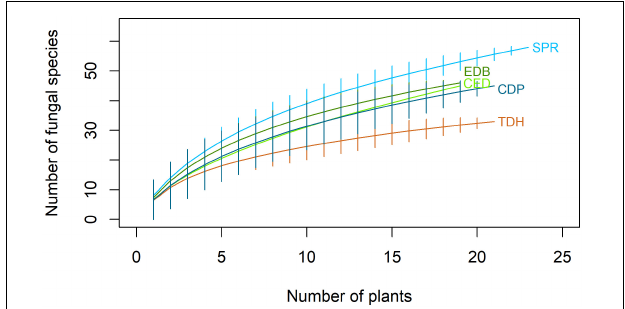
FIGURE 3 | Species accumulation curves for fungal species isolated from roots of Festuca rubra subsp. pruinosa at five populations from marine cliffs in northern Spain. TDH, Torre de Hércules; CED, Cedeira; EDB, Estaca de Bares; SPR, San Pedro de la Rivera; CDP, Cabo de Peñas.